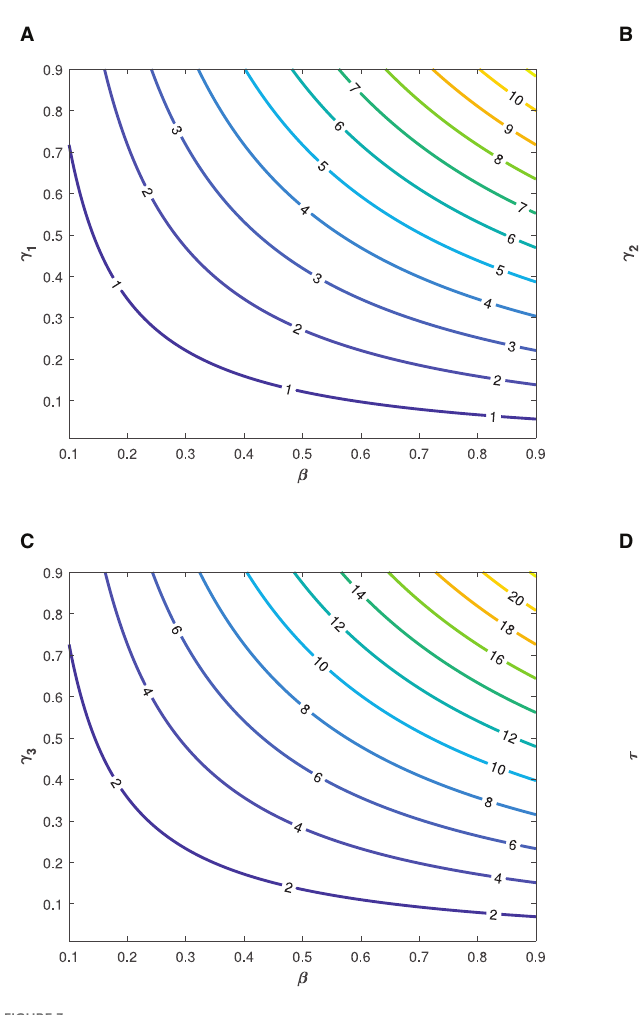
FIGURE3 Contour plots showing the impact of various parameters on the basic reproduction number R 0 as functions of (A, B) , β and γ 2 , (C) β and γ 3 , and (D) τ and ρ